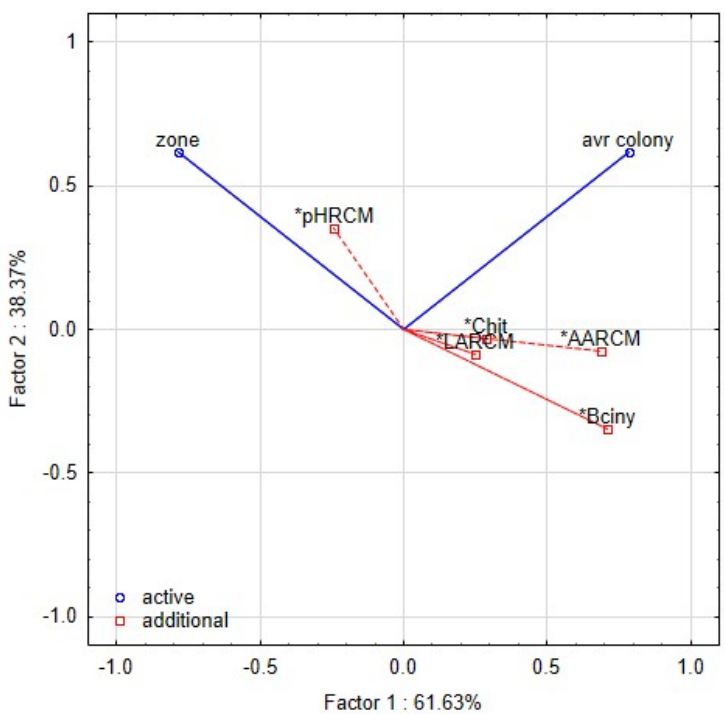
Figure 7. Biplot representing the first two components of PCA performed on the standardised values of index logarithms representing the interaction among lactobacilli and yeast contaminants in the overlay method. The functional properties of L. plantarum strains are included as additional factors. Asterisk notes the functional traits—pH, LA (lactic acid), AA (acetic acid), Bciny (bacteriocins), Chit (chitinase).